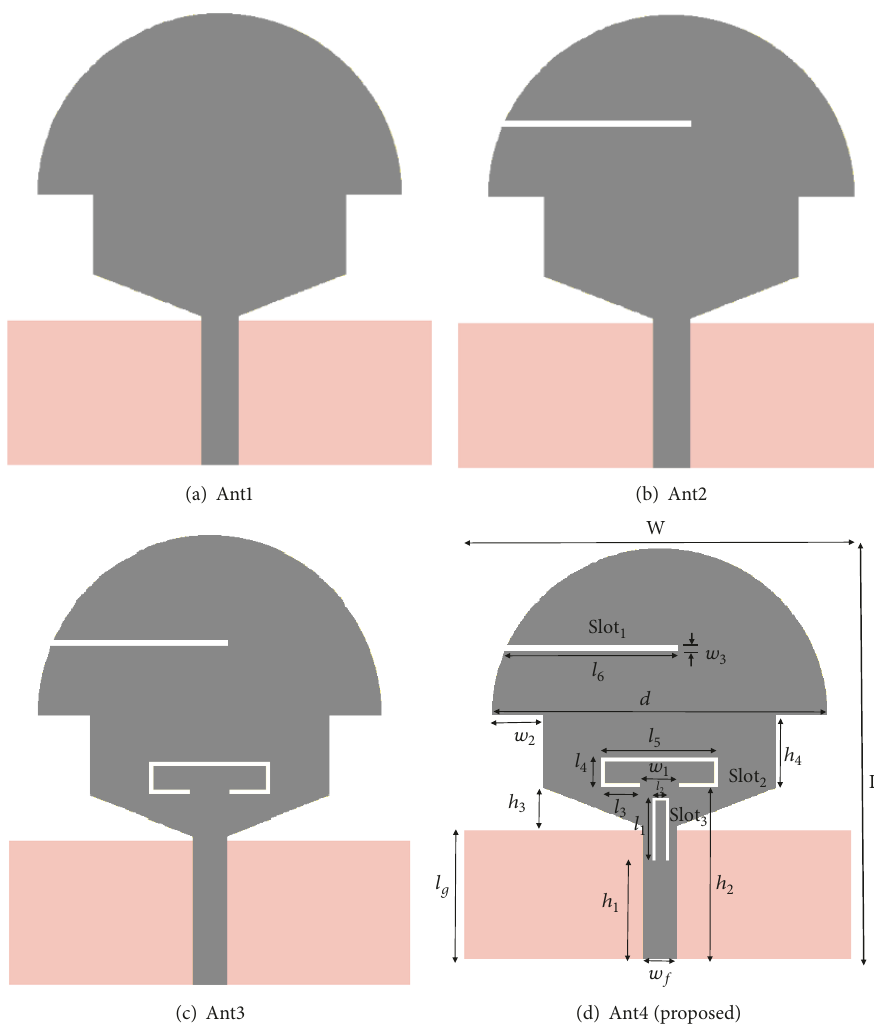
Figure 1: Structural evolution of the proposed UWB antenna (a) Ant1: UWB (3-10 GHz) (b) Ant2: UWB with Single Band (WiMAX) rejection features (c) Ant3: UWB with dual band (WiMAX and WLAN) rejection features (d) Ant4: UWB with triple band (WiMAX, WLAN, and ITU) rejection